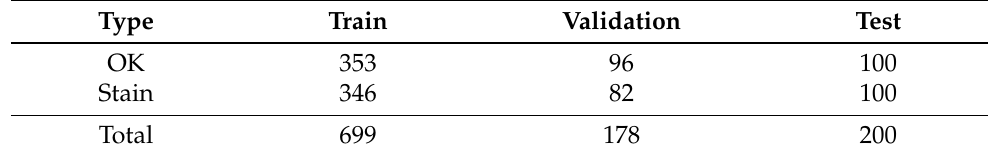
Table 5. Compact camera module